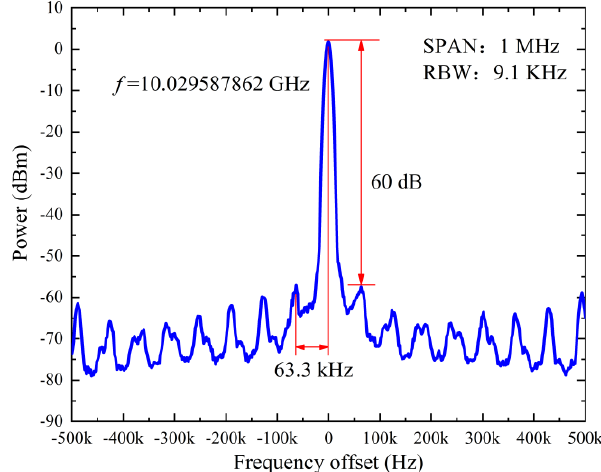
Figure 3. The generated 10 GHz microwave power spectrum of the coupled dual-loop SBS-based TOEO.